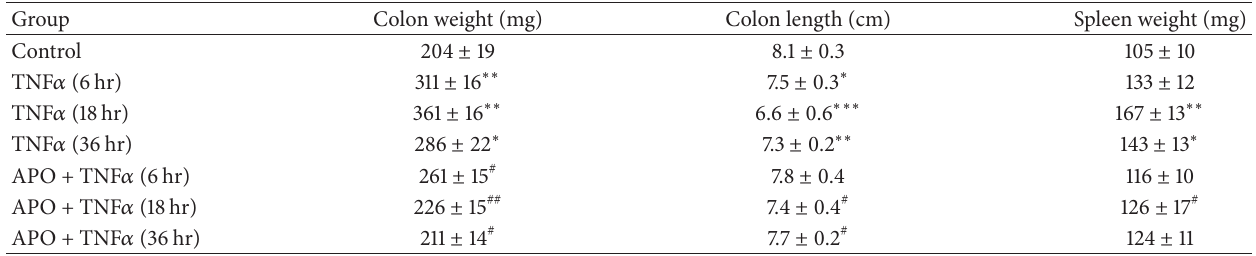
Table 1: TNF 𝛼 -induced colitis results in morphological alterations of the colon and spleen, an effect that is prevented by